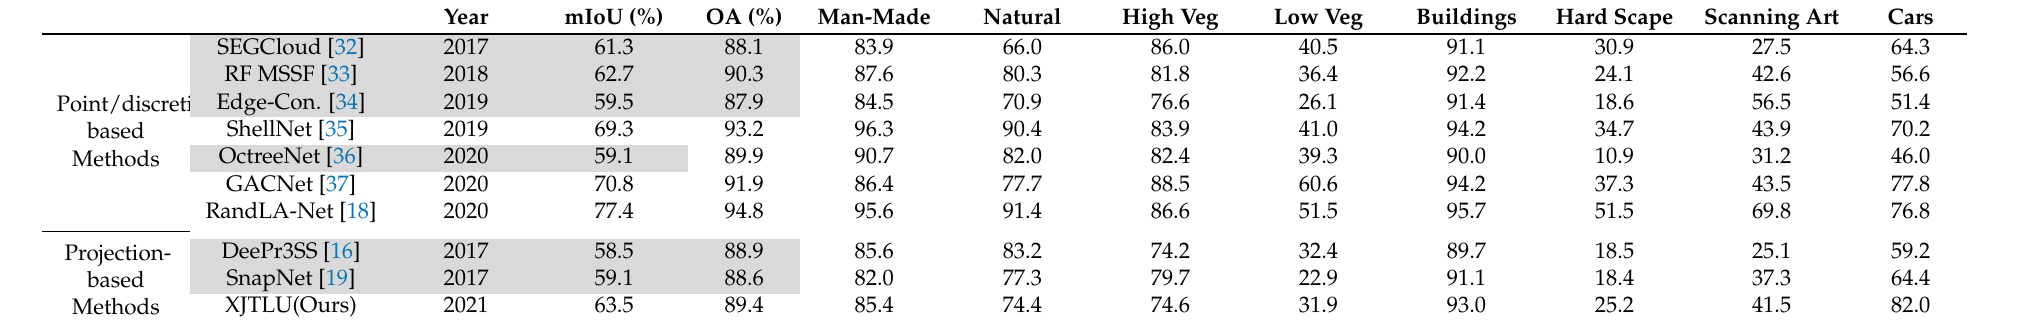
Table 8. Quantitative results of different approaches on Semantic3D (reduced-8) [20]. Accessed on 16 March 2021 (the overperformed methods are marked in